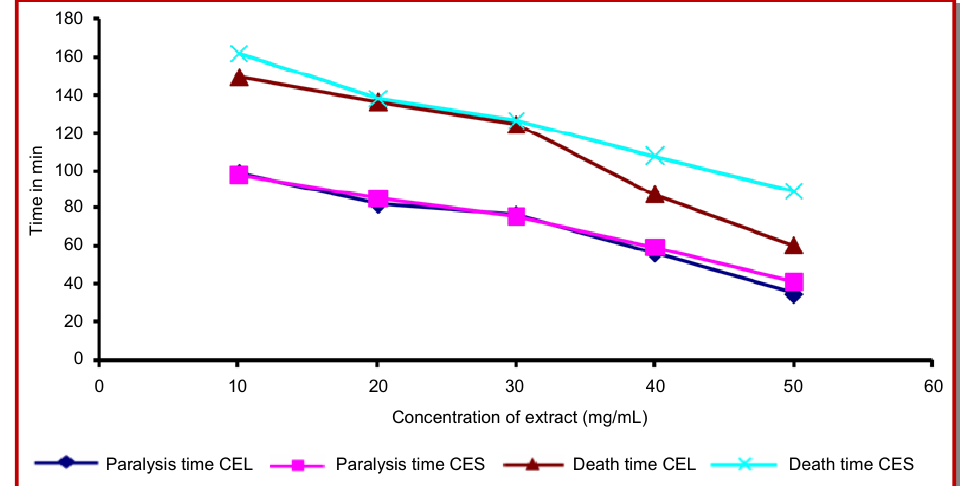
Anthelmintic activity of crude methanolic extracts of leaves and stems of Justicia gendarussa against Phereti- Conc.